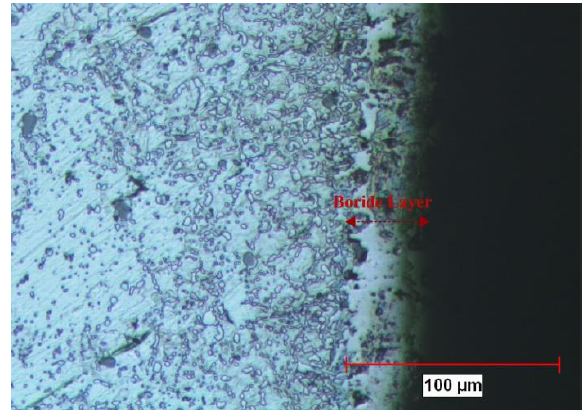
Figure 4. Optical microstructure image of borided AISI 430 material.